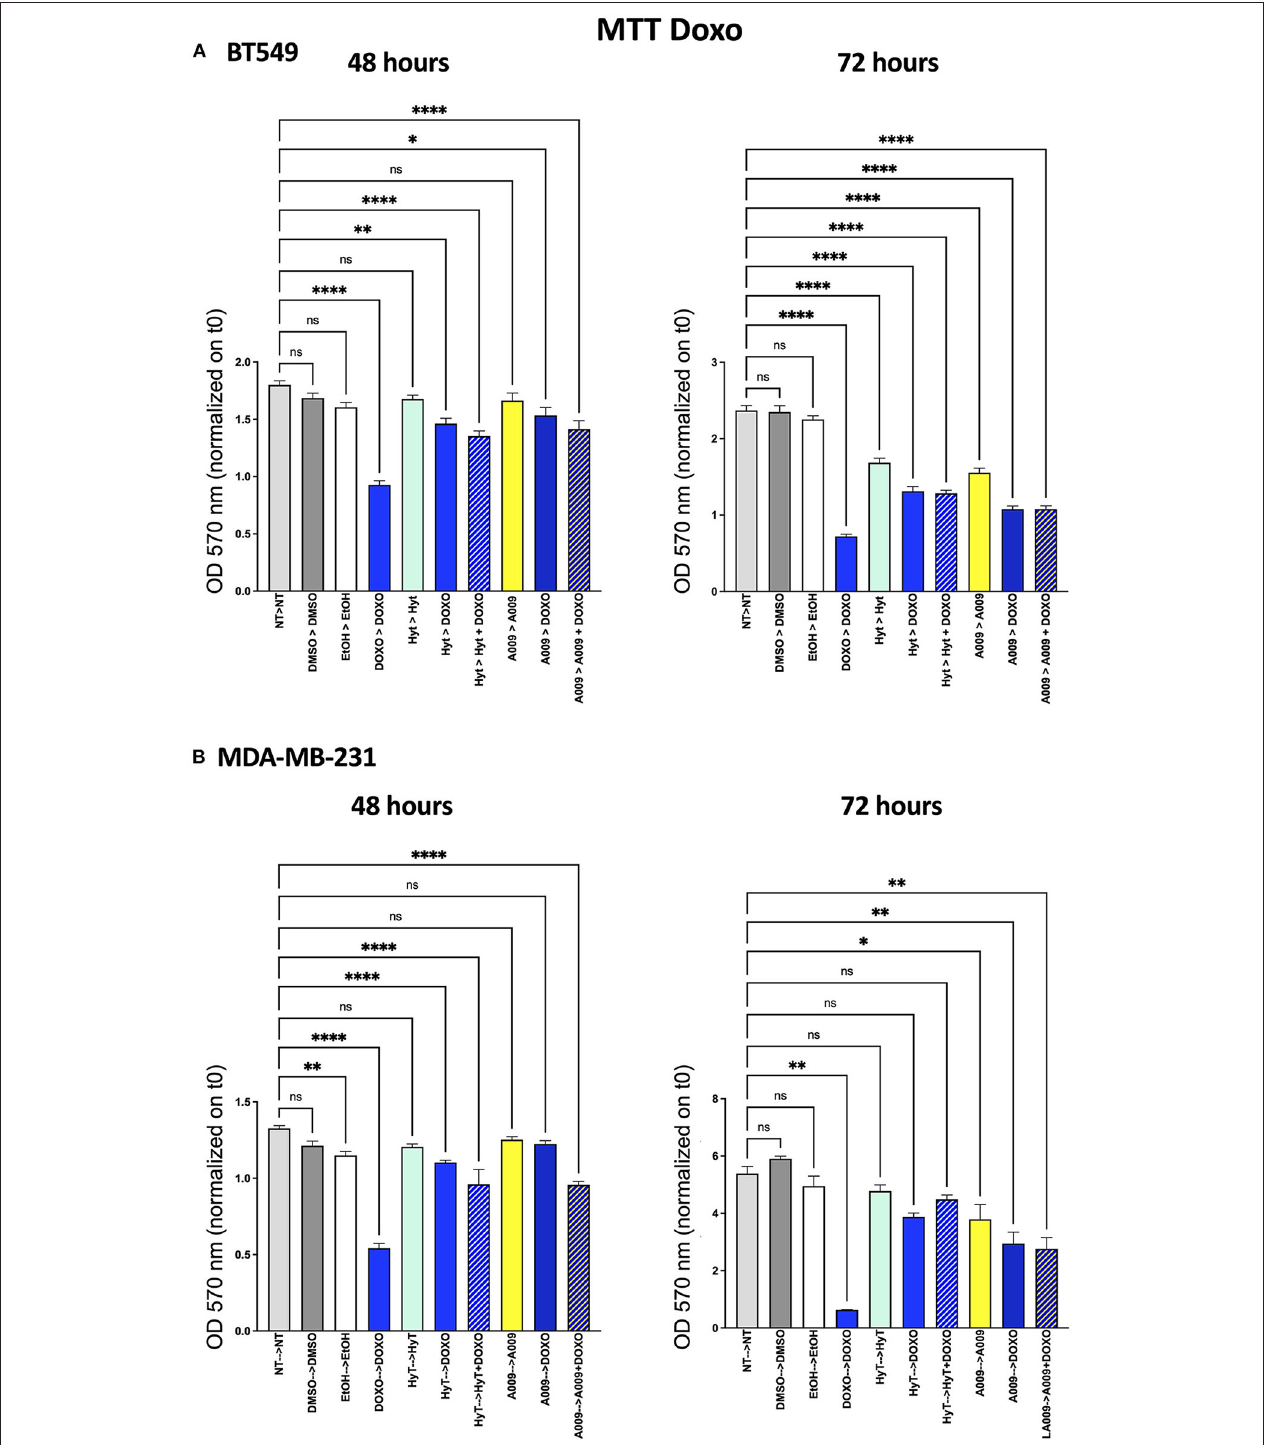
FIGURE 3 | Effects of the A009 extract in combination with doxorubicin on breast cancer cell lines. BT549 (A) and MDA-MB-231 (B) cells were pretreated with extract A009 (dilution 1:800) or Hyt (same concentration as that present in the 1:800 diluted A009 extract), for 24h. Later, the medium was replaced with doxorubicin 1 µ M alone or in combination with A009 or Hyt for 48 and 72h. Proliferation was detected by the MMT assay at the indicated time points. The experiments were performed in quadruplicate and repeated two times. Results are expressed as the mean of the absorbance normalized on the T0 0.05, ** p < 0.01, and **** p < 0.0001. A009 activity was enhanced by addition of chemotherapy toward breast cancer cells.